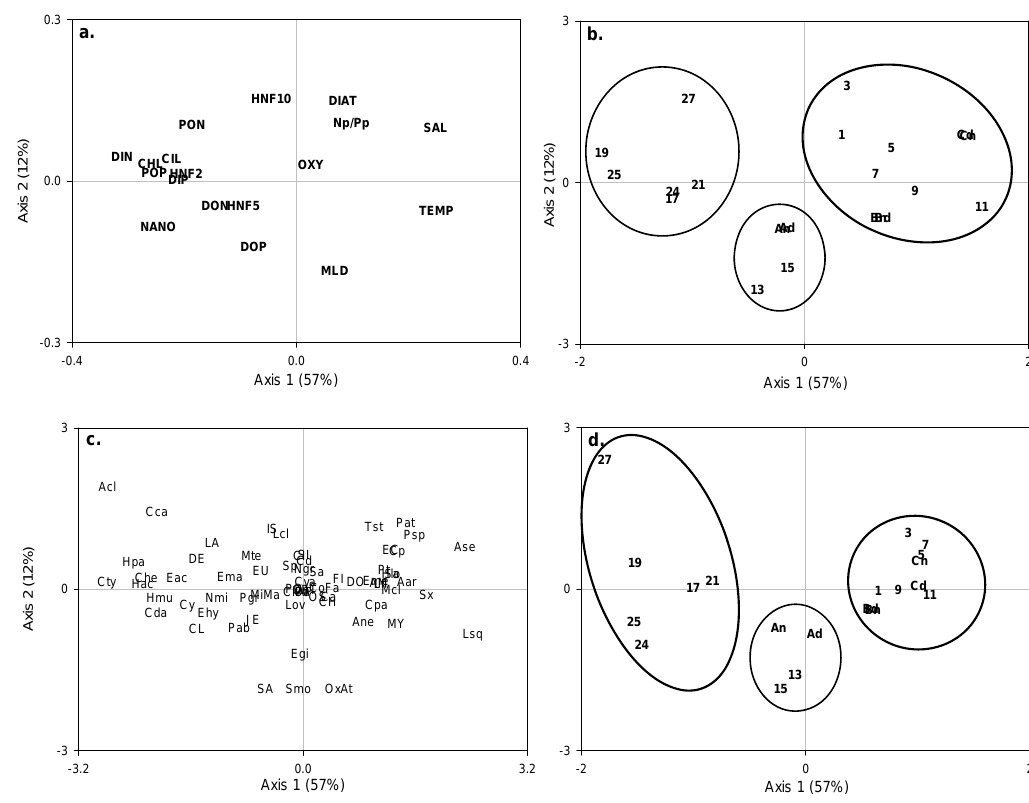
Fig. 9. Co-inertia analysis: plots of the environmental variables (a) and the stations (b) in the “Environment” system and plot of the taxa (c) and the stations (d) in the “Zooplankton” system. Circles corresponded to cluster group tested with non parametric MANOVA. Mixed Layer Depth (MLD), Aetideus armatus (Aar), Arietellus setosus (Ase), Calanoides carinatus (Cca), Clytemnestra spp. (Cy), Copilia spp. (Cp), Euaetideus giesbrechti (Egi), Euchaeta marina (Ema), Euchirella messinensis (Eme), Haloptilus acutifrons (Hac), H. longicornis (Hlo), H. mucronatus (Hmu), Heterorabdus papilliger (Hpa), Lubbockia squilimana (Lsq), Lucicutia clausi (Lcl), L. flavicornis (Lfl), L. ovalis (Lov), Phaenna spinifera (Psp), Sapphirina spp. (Sa), Amphipods (AM), Cirriped larvae (CI), Isopods (IS), Oxygyrus / Atlanta spp. (OxAt) and Pterotrachea spp. (Pt). Other abbreviations as in Tables 2 and 3.